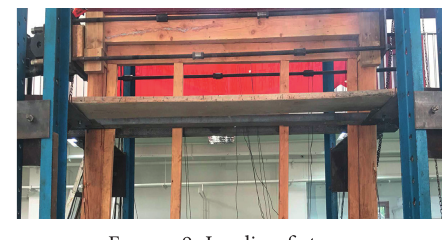
Figure 9: Loading fixture.